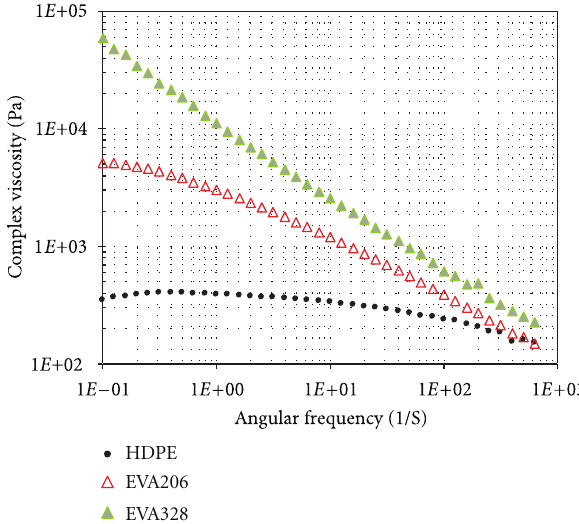
Figure 5: Complex viscosity of the pure